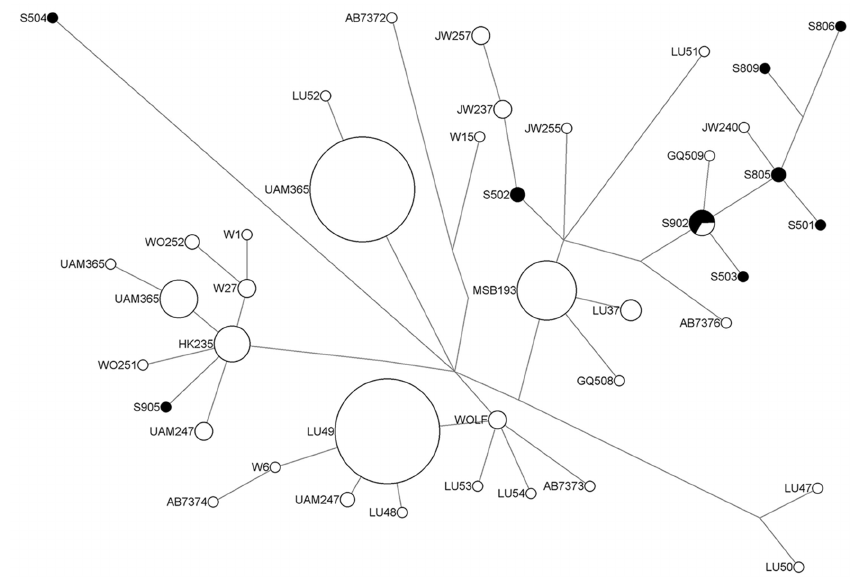
Fig 3. Median-joining network of wolf specimens for the mitochondrial DNA control region. Black circles indicate samples from our study. Sequences analyzed in the network span nucleotide positions 15547 – 15792. See Table 1 for the sample IDs from this study. Notable haplotypes include GQ509 (GenBank Accession No. GQ376509; Ural mountains of Russia [59]), JW237, 240, 255, 257 (GenBank Accession